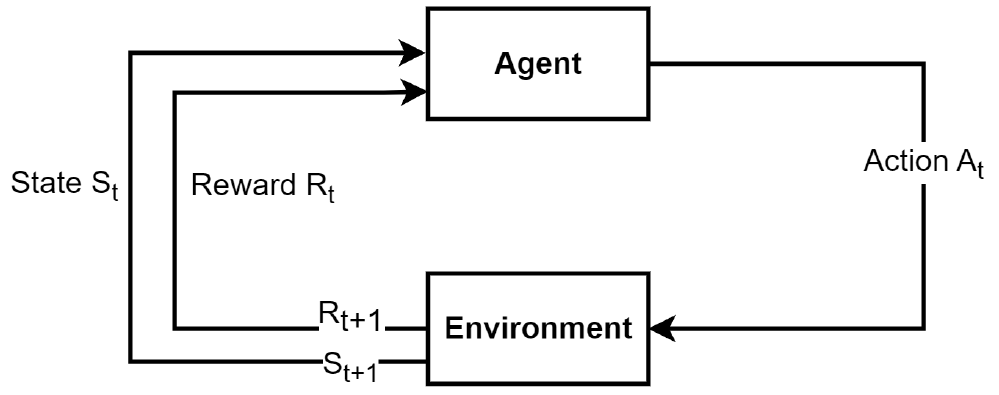
Figure 1. basic RL